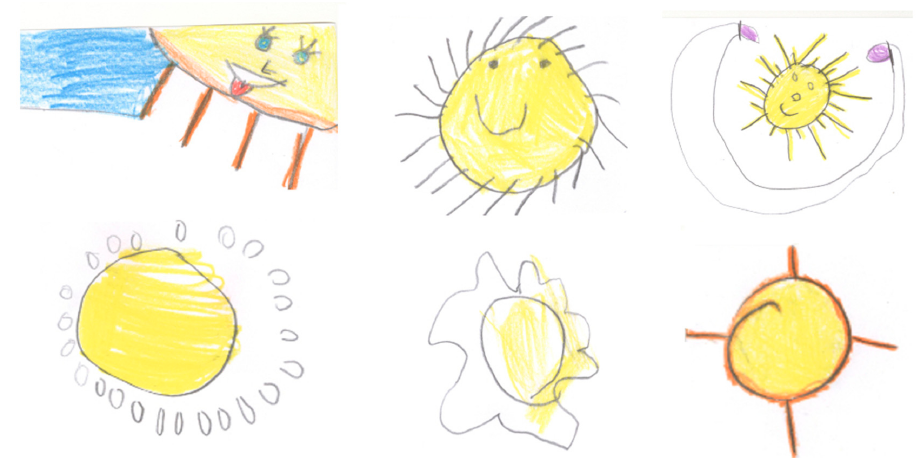
Figure 1. Some examples of the anthropomorphic and non-anthropomorphic representations of the sun found in the sample under study.